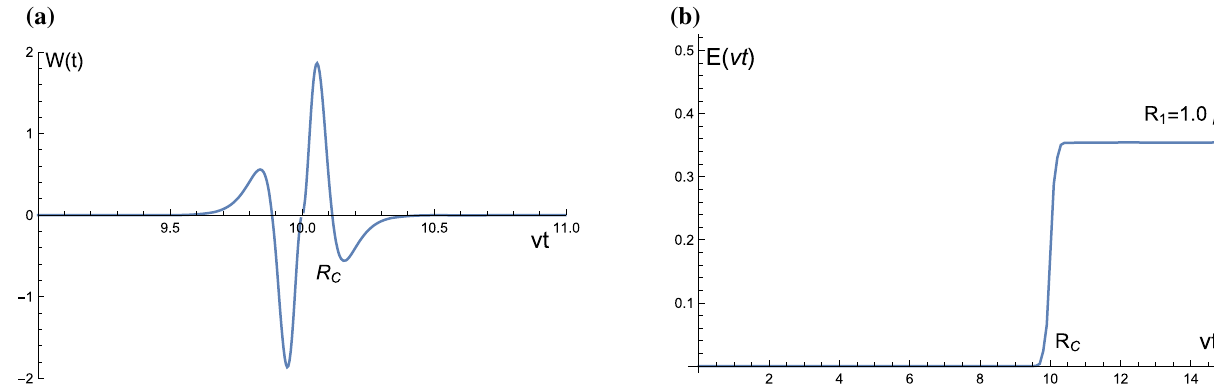
Fig. 7 a Emitted power taking into account the direction of the field. b The structure of the emitted energy as a function of the penetration distance